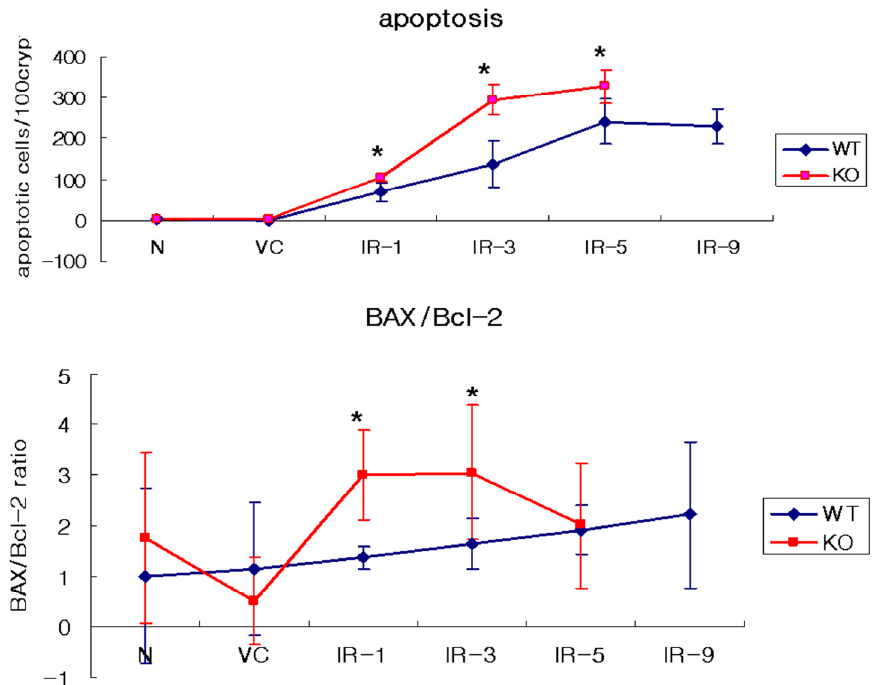
Figure 5. Comparison of apoptotic cells and the BAX/Bcl-2 ratio in the WT and SMP30 KO mice. The BAX/Bcl2 ratio significantly increased only in the 1 Gy and 3 Gy groups, while apoptosis increased in the 1 Gy, 3 Gy, and 5 Gy